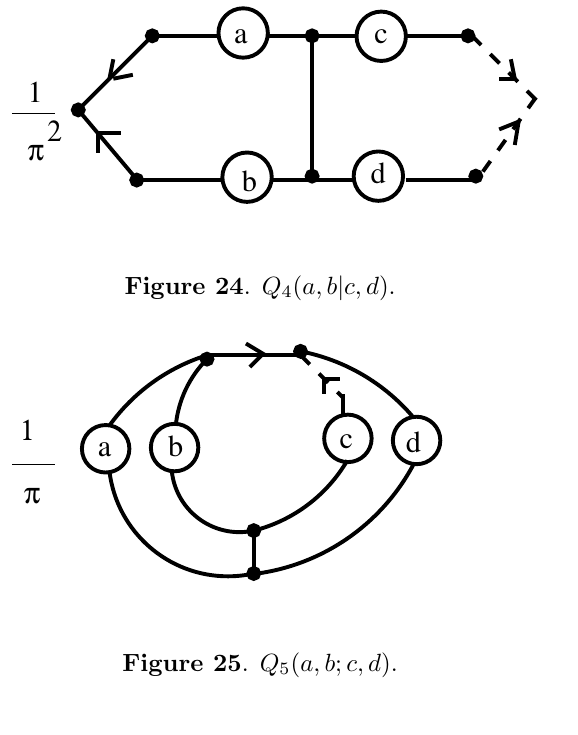
Figure 25 . Q 5 ( a; b ; c; d